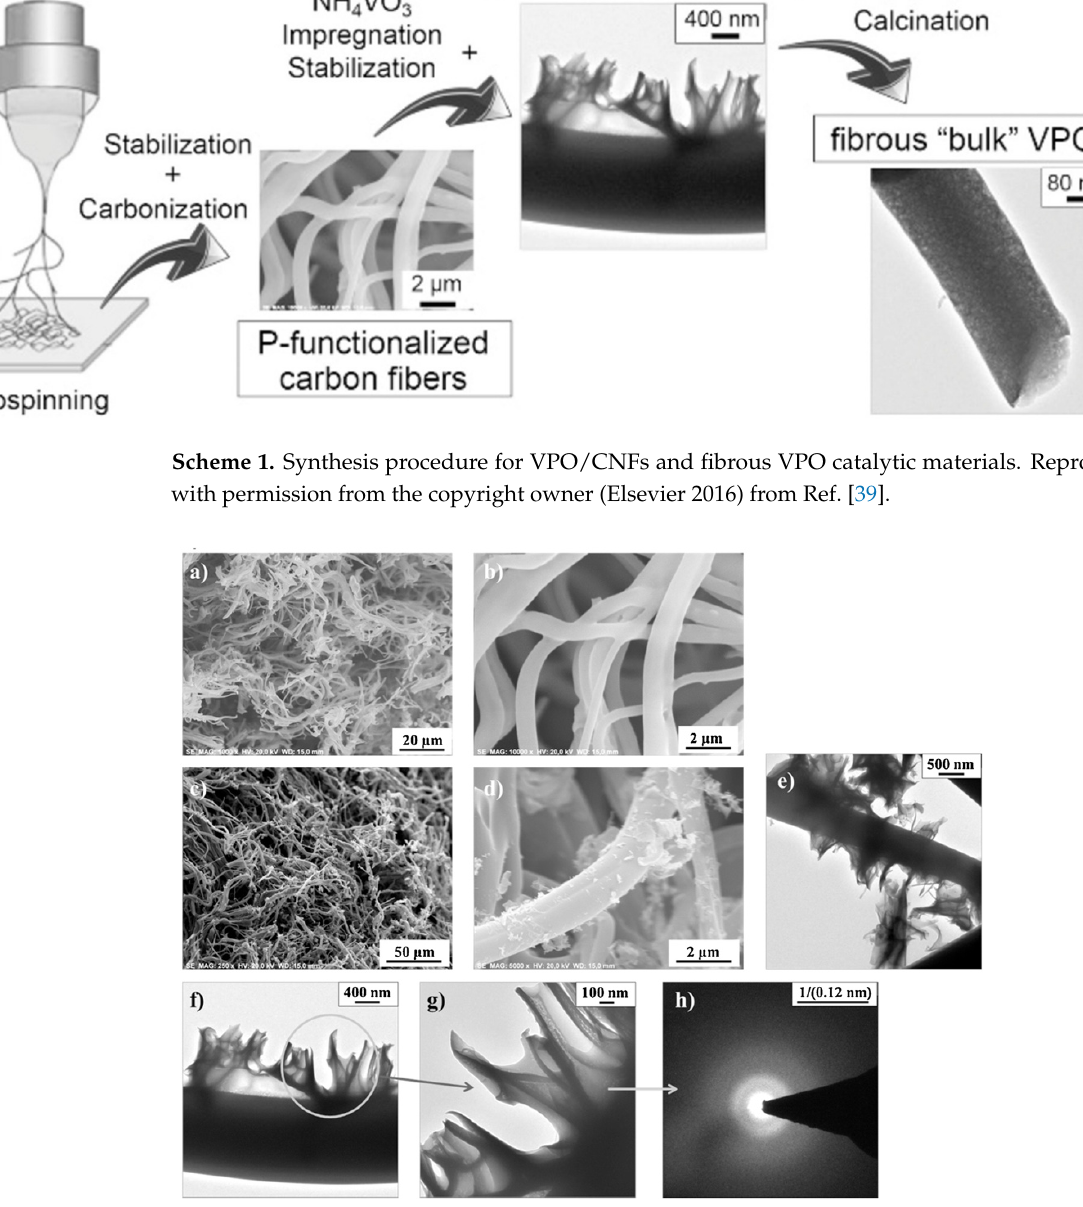
Figure 3. SEM and TEM ( a , b , d – g ) images of VPO fibrous catalysts at different magnifications and SAED analysis ( c , h ). Reproduced with permission from the copyright owner (Elsevier 2016) from Ref. [39].